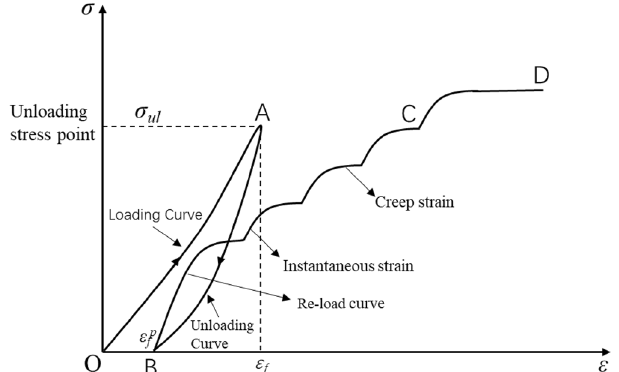
Figure 4. Schematic diagram of pre-peak unloading damaged rock sample preparation and the reloading test.